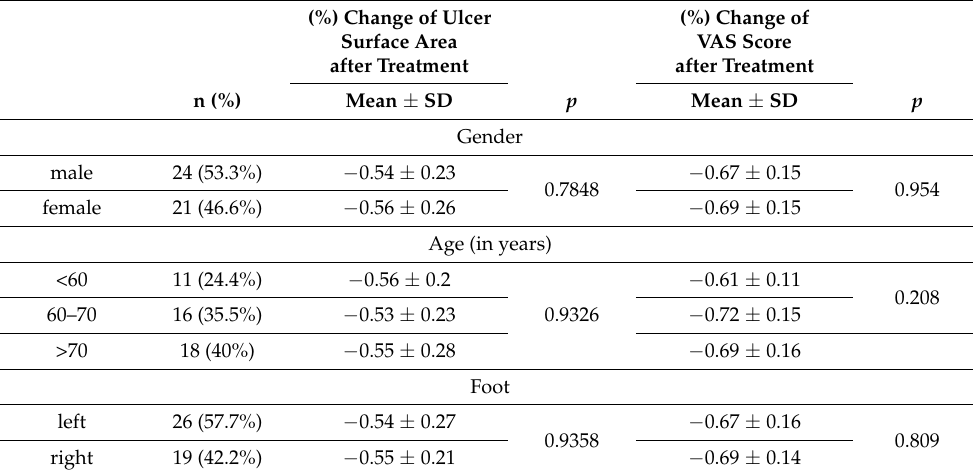
Table 3. The mean percentage change of the ulcer surface area assessed by planimetric method and pain intensity assessed using a VAS after the applied treatment with local HBO by gender, age, and ulcer location, including the results of statistical